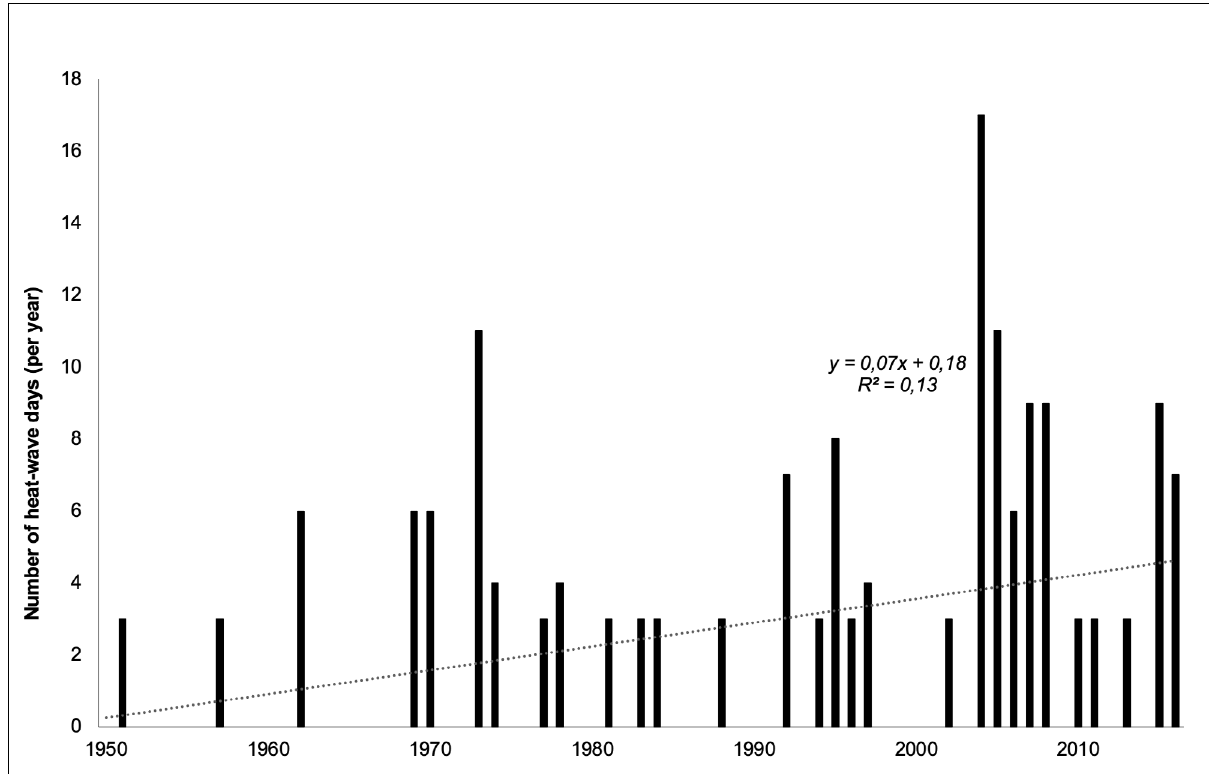
Figure 5: Number of heatwave days per annum for northernmost Limpopo Province, based on mean maximum temperature for the hottest month (January). The value for determining the threshold for a heatwave in northernmost Limpopo Province is 38.9 °C (i.e. 33.9 °C + 5 °C).